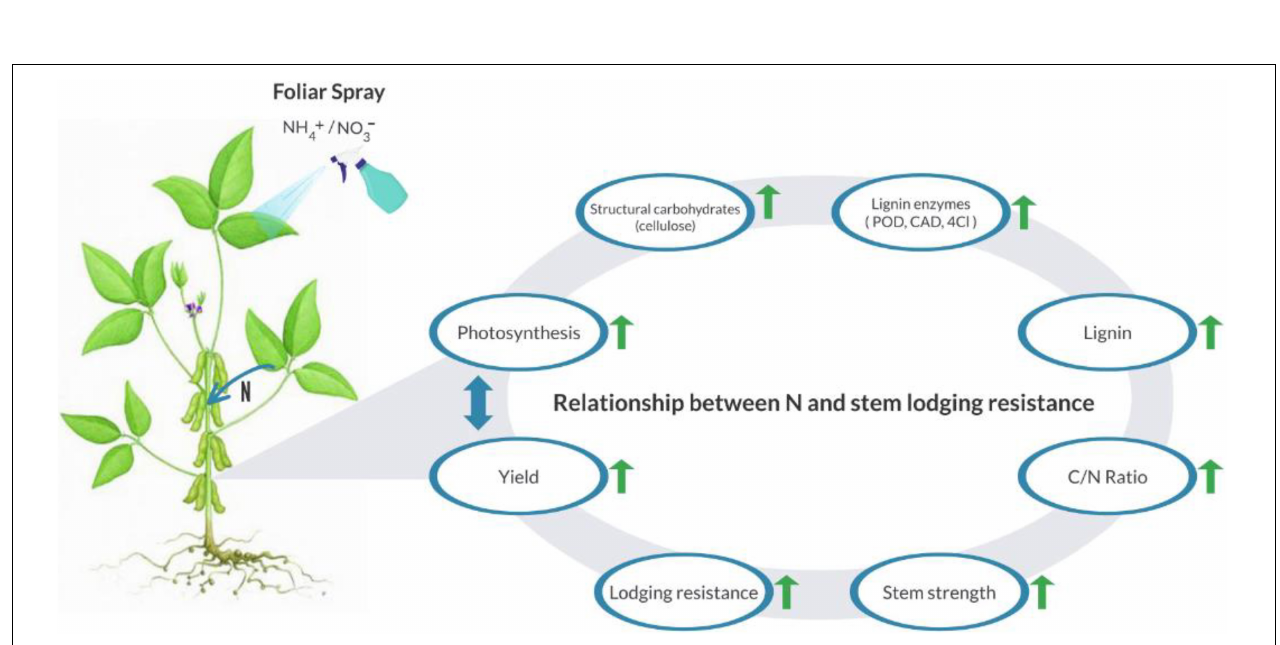
FIGURE 9 | Relationship between stem characteristics, lignin content, and related enzyme activities. The following are the abbreviations used in the figure: lodging resistance index (LRI), and plant height (PH), stem diameter (SD), cellulose content (CC), lignin content (LC), photosynthetic rate (Pn), peroxidase enzyme activity (POD), cinnamyl alcohol dehydrogenase enzyme activity (CAD), 4-coumarate CoA ligase enzyme activity (4CL), sucrose content (SUC), and stem strength (SS) of soybean stem. The circle size showed the significant level and the circle color exhibited the positive or negative correlations. The significance difference among different parameters was showed by the *, ** at the probability level of p ≤ 0.05, p ≤ 0.01.